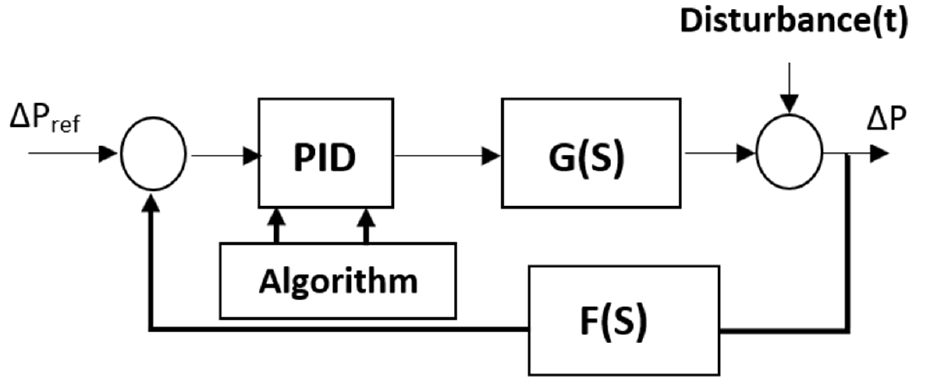
Figure 11. Small signal module feedback control system.